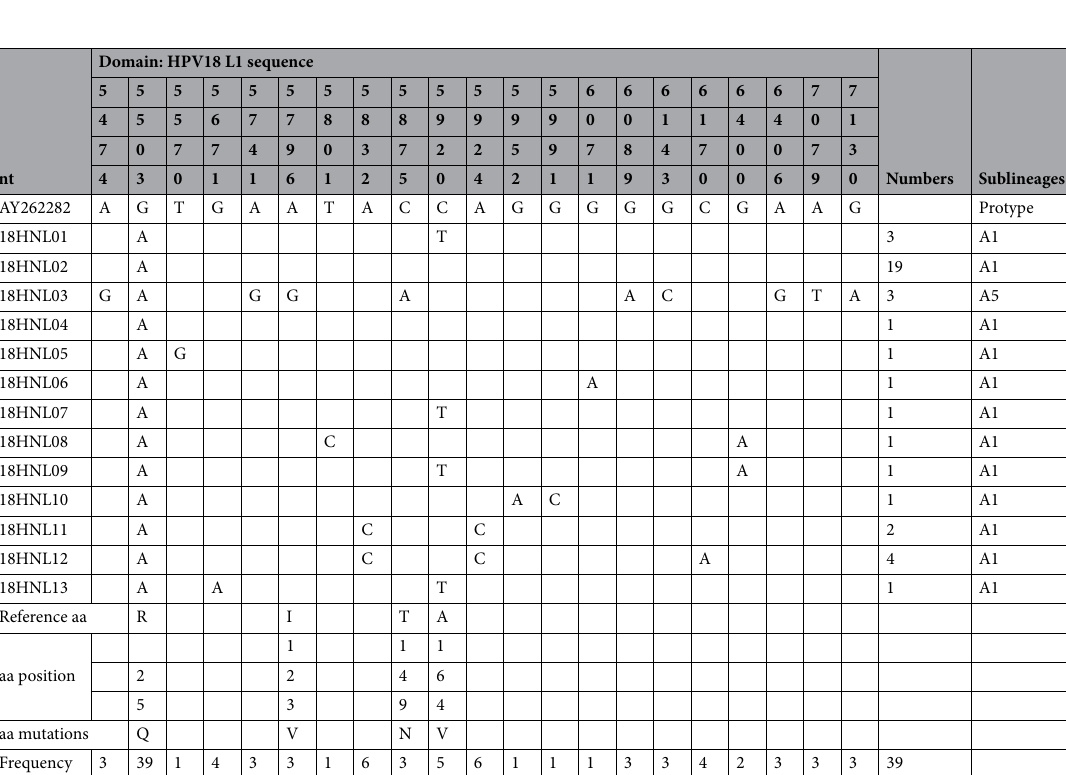
Figure 1. Prevalence of the HPV infection types in different age groups.